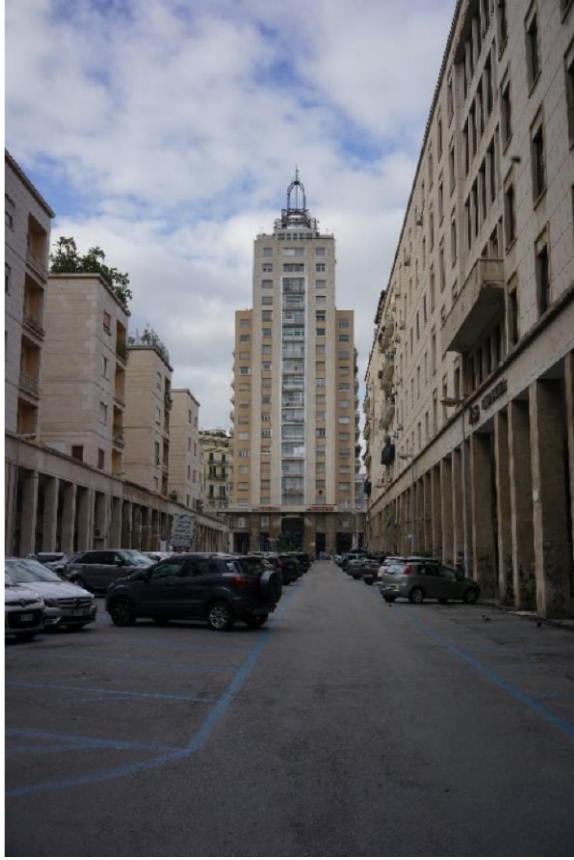
Figure 16: Perspective and front view of the outer orientation of the image taken with a standard mirrorless camera.